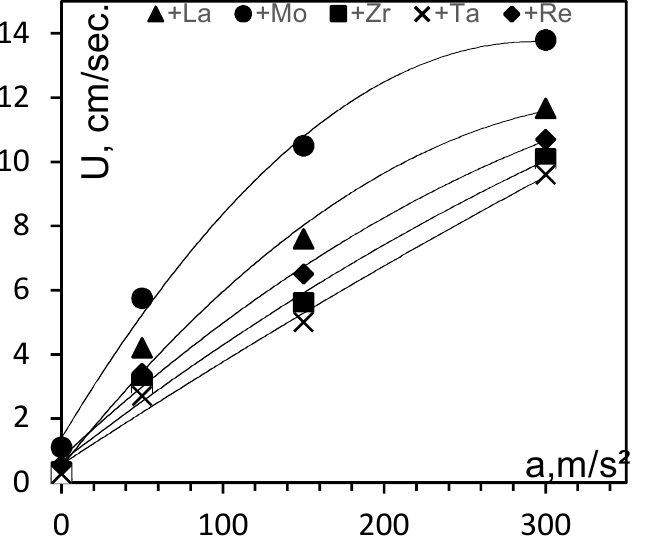
Figure 2. The effect of acceleration ( a ) and added modifying agents ( X ) on the combustion velocity ( U c ) of the mixtures during synthesis of NiAl–Cr–Co– X cast alloys, where X = La, 2.5%Mo, Zr, Ta, and Re.